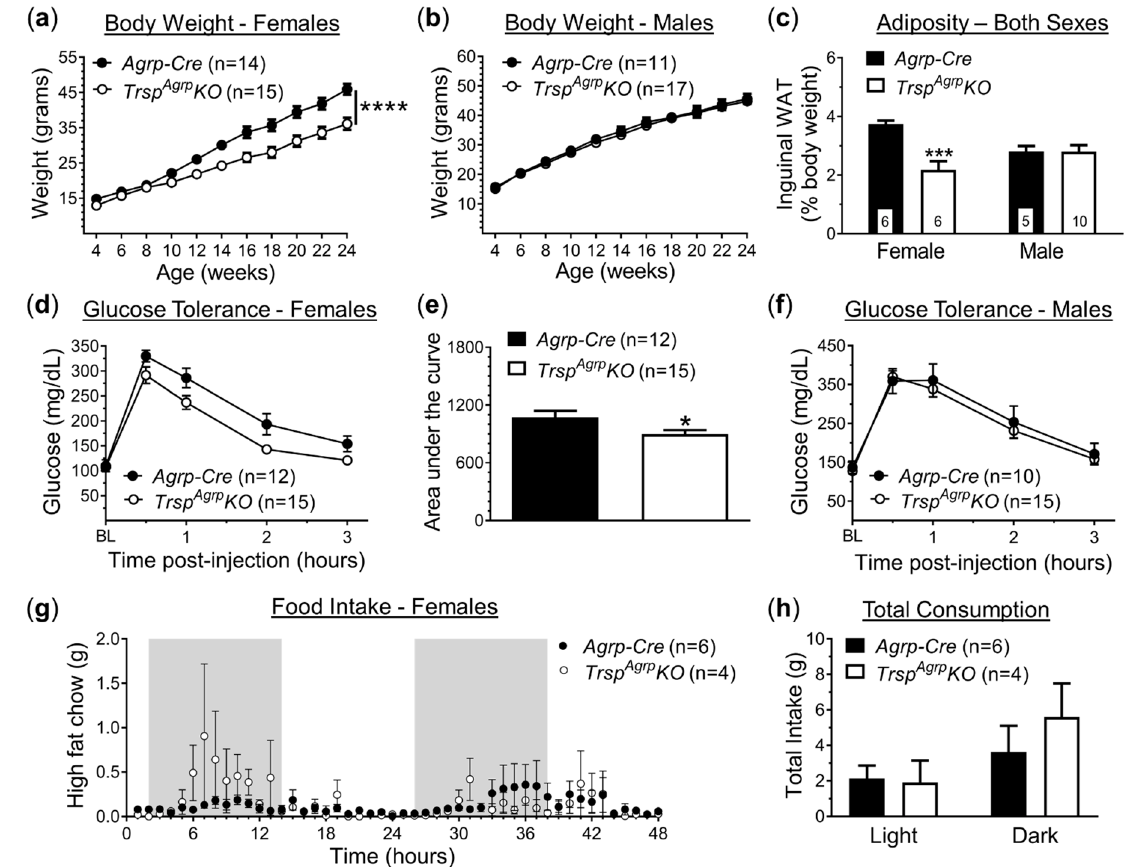
Figure 1. Metabolic profile of TrspAgrpKO mice of both sexes raised on a high-fat diet. Female TrspAgrpKO mice ( a ) gained less weight while on a high-fat diet compared to Agrp-Cre controls; however, there was no effect of TrspAgrpKO in the body weight of male mice ( b ) (Sidak’s multiple comparisons test following repeated measures: **** p < 0.0001). Inguinal white adipose tissue (WAT) deposits weighed less in female TrspAgrpKO mice ( c ) and were unchanged in male TrspAgrpKO mice (Tukey’s multiple comparisons test following two-way analysis of variance: *** p = 0.0008). Glucose tolerance was elevated in female TrspAgrpKO mice ( d , e ) compared to controls (unpaired t -test comparing area under the curve: * p = 0.03) and remained unaffected in males ( f ). Feeding behavior ( g , h ) was not significantly changed in TrspAgrpKO mice of either sex during 48 h recordings. Samples sizes are displayed in the graphs. All values shown are mean ± standard error of the mean.